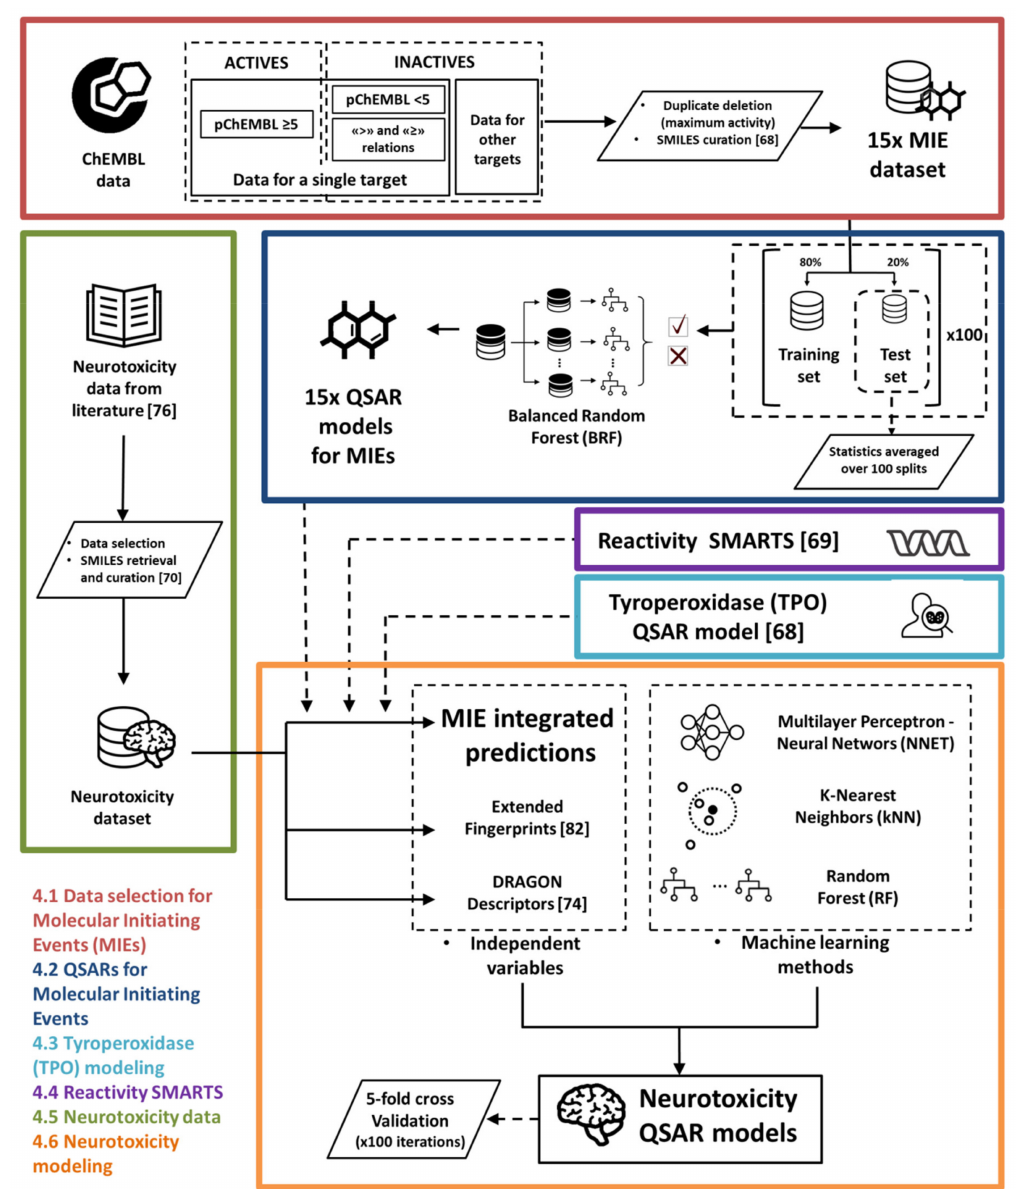
Figure 2. Modeling workflow. The colours of the various blocks refer to the paragraph in Materials and Methods that describes the specific steps of the workflow. Data from ChEMBL for 15 targets relevant for the MIEs of neurotoxicity (red) were classified based on the threshold pChEMBL = 5; negative samples were enriched with data using “>” and “ ≥ ” qualifiers and with chemicals from other MIE data that were treated as decoys. QSARs for MIEs (blue) were developed from these datasets using the BRF method. Datasets were iteratively partitioned into training and test sets and their external performance was calculated as the average of the various iterations; then, the models were retrained on the whole datasets. Neurotoxicity data (green) were retrieved from [76] and curated at the SMILES level. Predictions from the thyroperoxidase model (violet) by [72] and reactivity SMARTS (cyan) by [75] were combined with the predictions from the 15 MIE modes and used as independent variables to develop neurotoxicity QSAR models (orange). kNN, RF, and NNET were used to develop models. The use of MIE predictions as independent variables was benchmarked with fingerprints and DRAGON descriptors; then, the performance of the obtained models was compared with five-fold cross